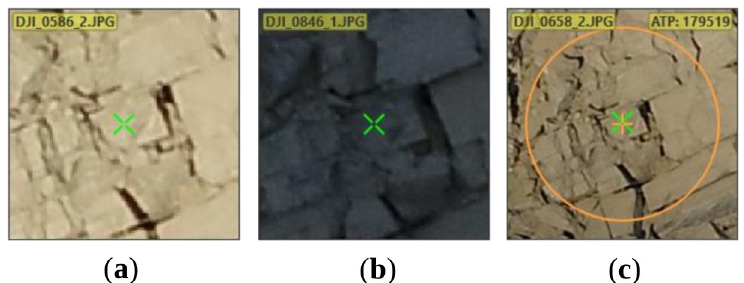
Figure 19. Images captured during a single flight using the same lens, filter, focal length and camera settings. The same location on the pit wall is identified by the green cross. ( a ) High glare caused by direct sunlight, ( b ) fully shaded and ( c ) indirect lighting environments were encountered while a shadow moved up the pit